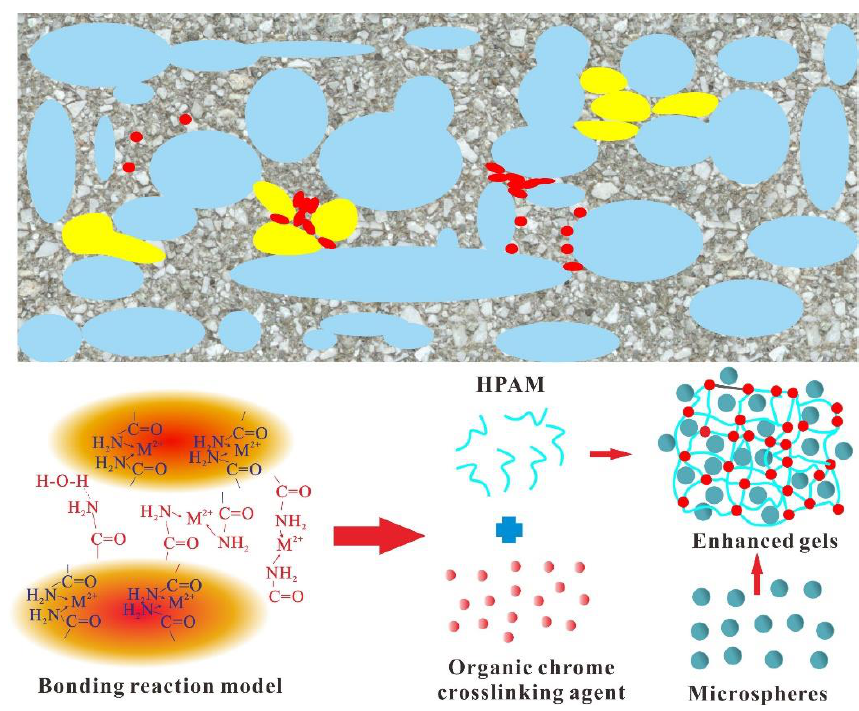
Figure 11. Formation mechanisms of enhanced gels with microspheres.